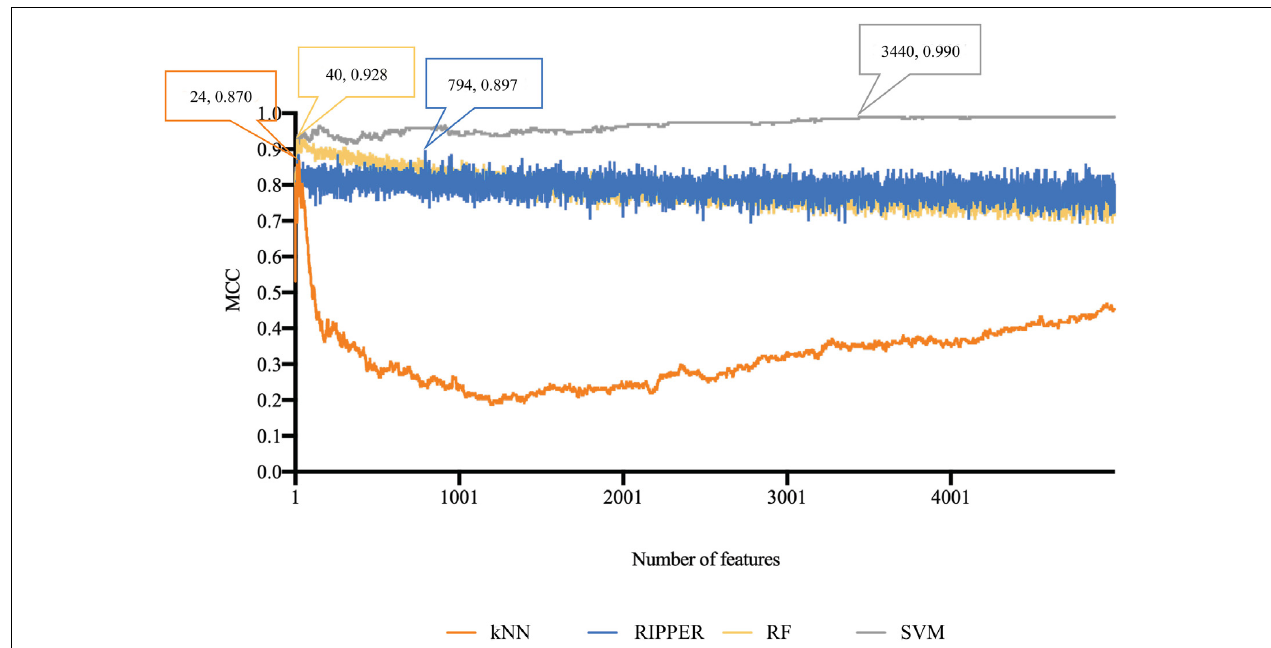
FIGURE 4 | Performance curves of IFS with RF, SVM, kNN, and RIPPER under different numbers of features for expression data. SVM generates the highest MCC of 0.990.